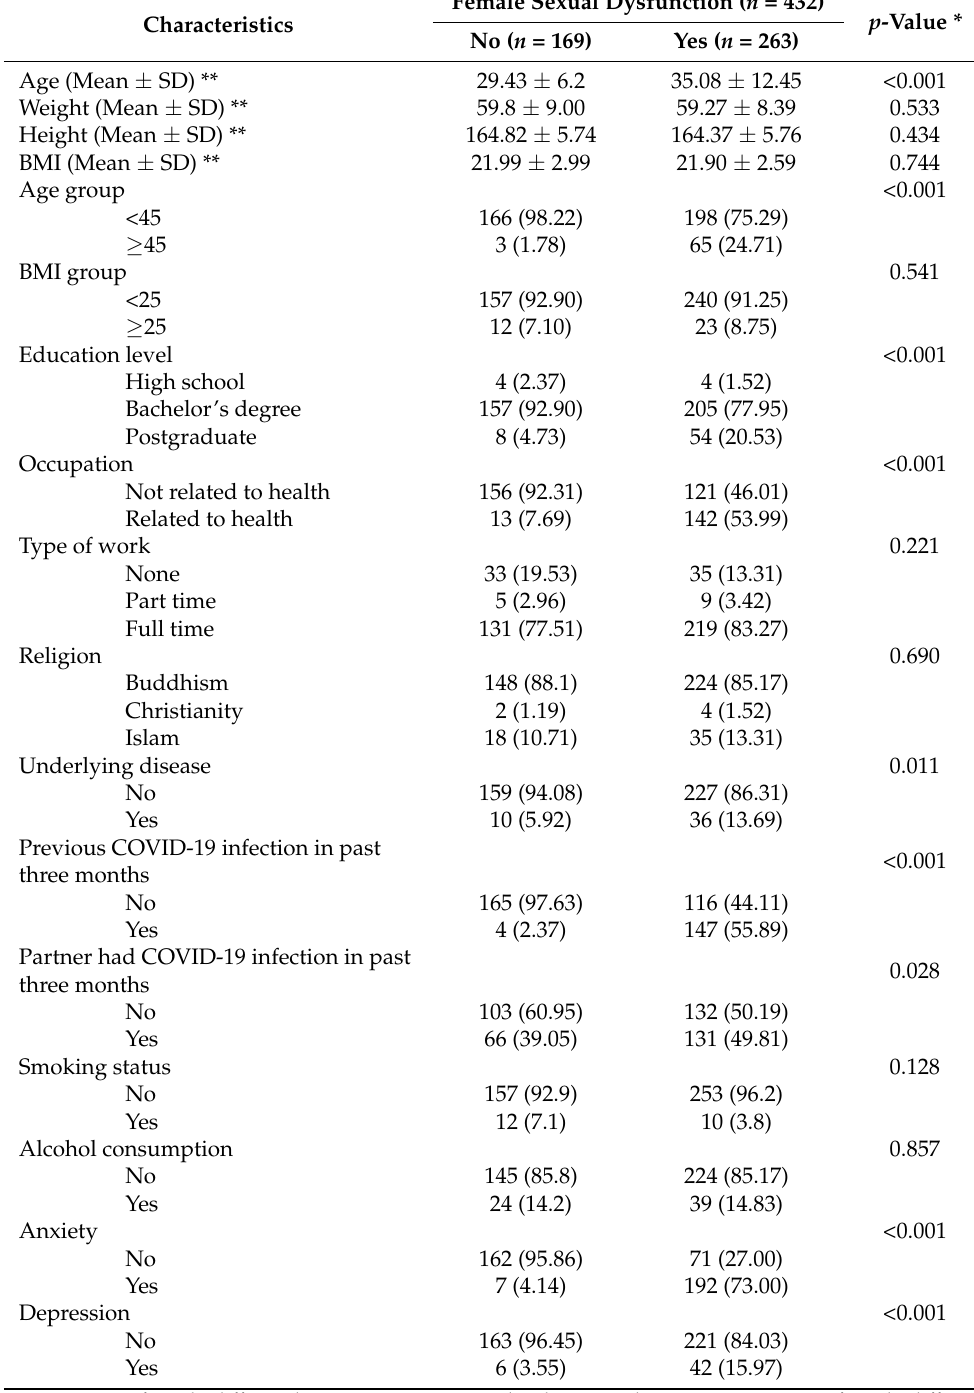
Table 3. Female sexual dysfunction ( n =